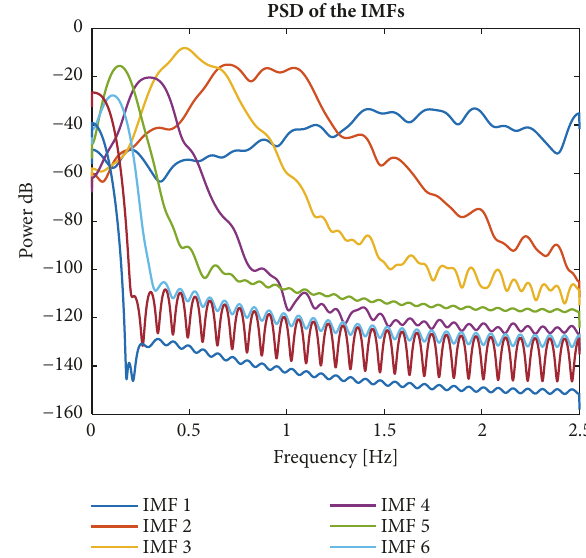
Figure 5: PSD estimate of the first 6 extracted IMFs in the analyzed segment.